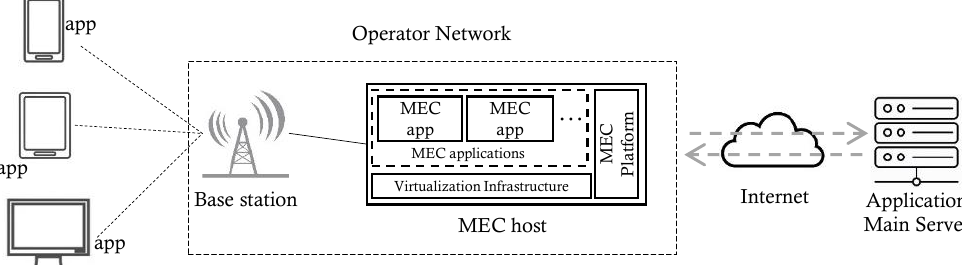
Figure 1. Overview of the network after deployment of MEC based on